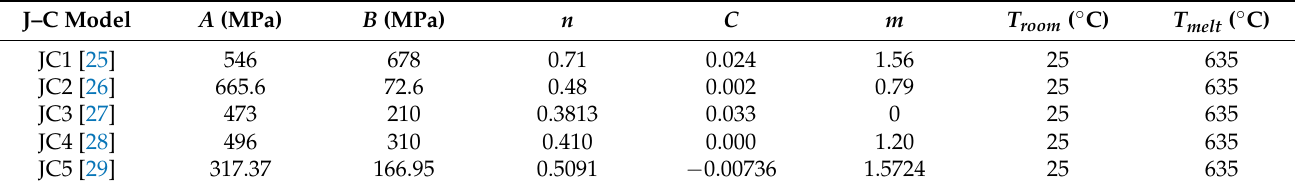
Table 1. 7075-T6 aluminum alloy material constants obtained by several research